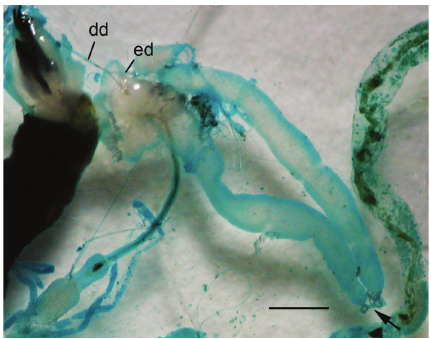
Figure 5: Light micrograph of the salivary gland in third instar C. megacephala revealing a translucent single median deferent duct (dd) bifurcated into two long, narrow e ff erent ducts (ed) terminally connected to the large tubular glands (arrow). Bar = 10 µ